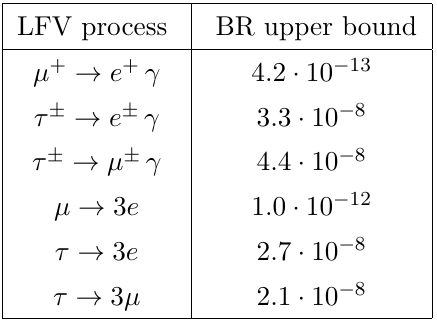
Table 1. Constraints on LFV processes, taken from [40]. The left column indicates rare LFV processes and the right one shows the corresponding upper limits on the branching ratios